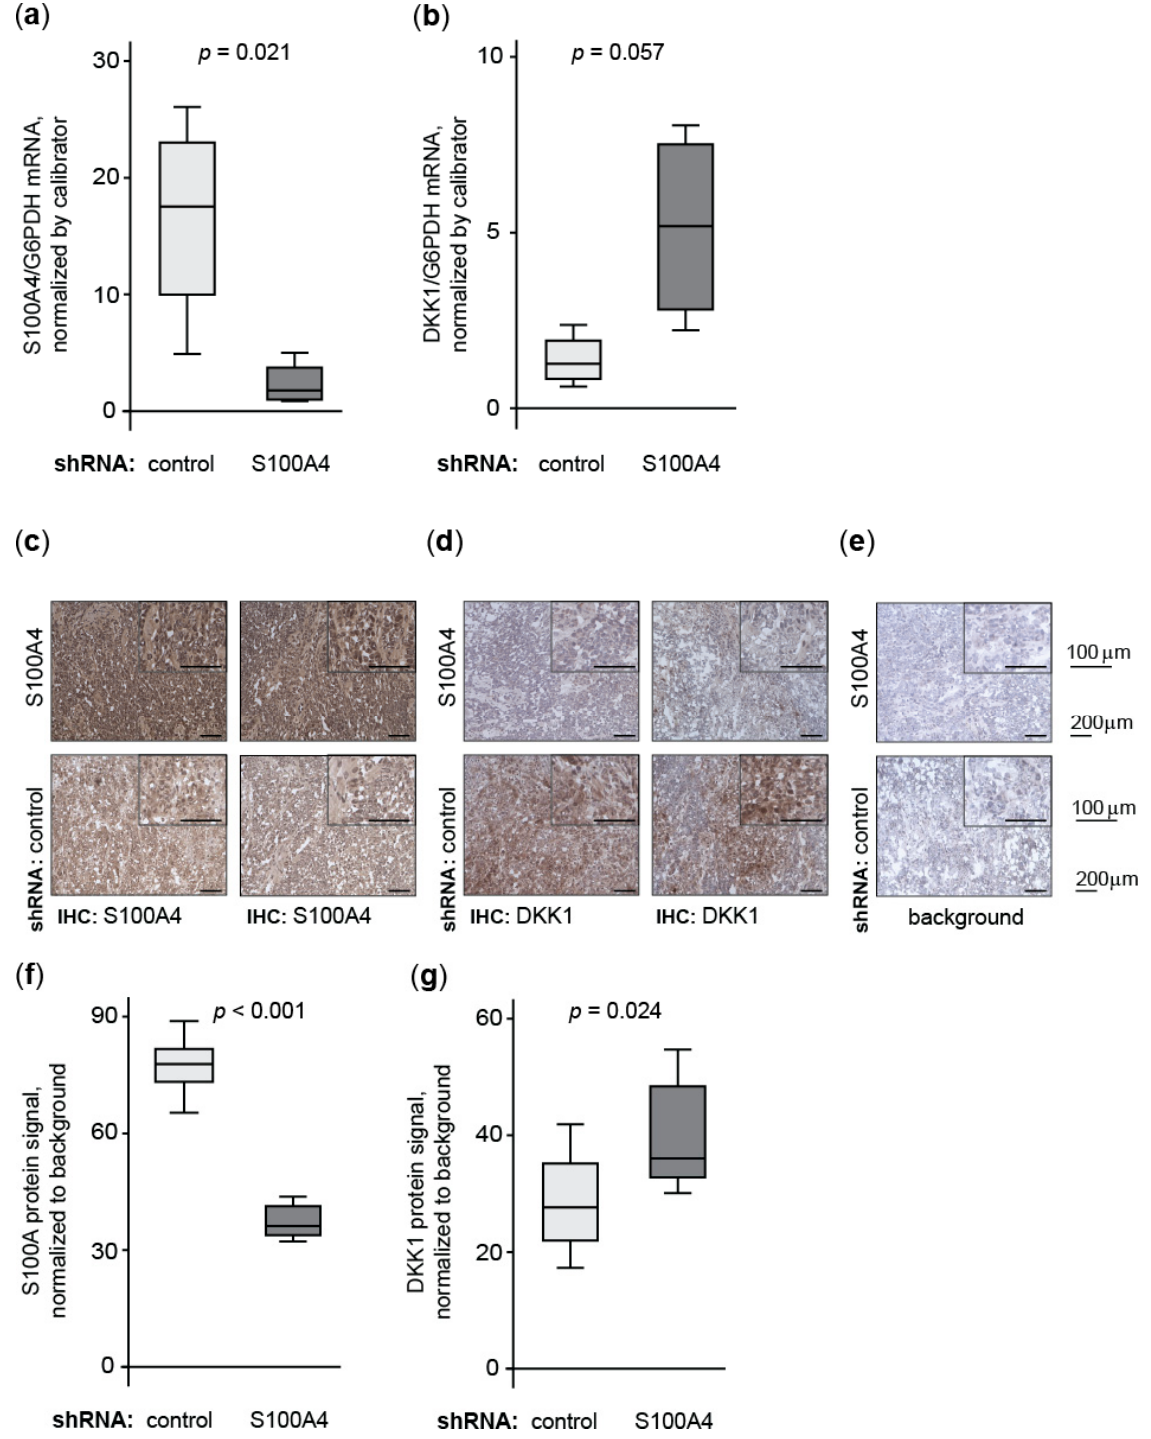
Figure 6. S100A4 reduction restores endogenous DKK1 expression in vivo. Relative mRNA expression of S100A4 ( a ) and DKK1 ( b ) in intrasplenic tumor tissue of xenografted mice receiving the systemic application of S100A4-specific shRNA expression plasmids. Immunostaining of S100A4 ( c ), DKK1 ( d ), and background control ( e ) of two independent samples per group of intrasplenic xenograft tumor tissue. Images were taken at 20 × and 40 × magnification, and scale bars represent 200 µ m and 100 µ m, respectively. Quantification of protein-specific immunostaining confirms the cross-regulation of S100A4 ( f ) and DKK1 ( g ) in vivo. Quantified expression of target genes occurred in triplicates of eight independent animal